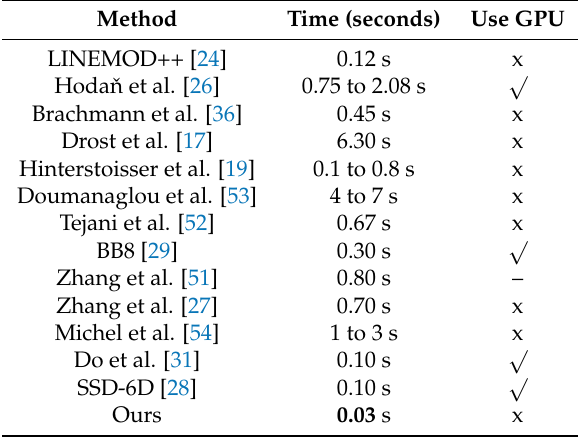
Table 4. Time comparison (seconds) of different methods for detection and pose